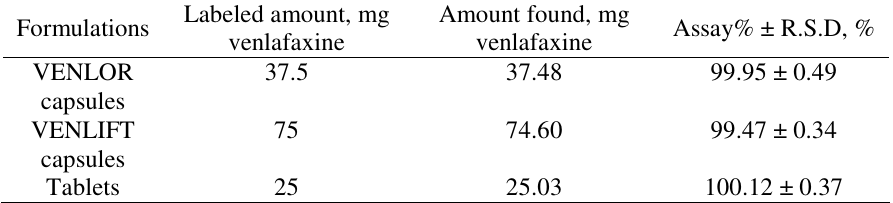
Table 11 . Analysis of venlafaxine hydrochloride from pharmaceutical formulations by proposed